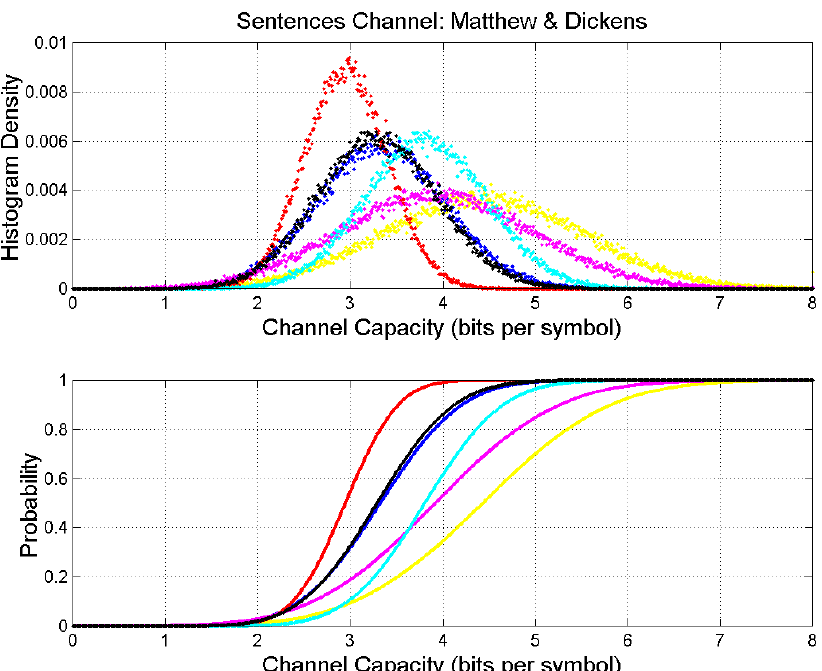
Figure 8. Upper panel : Probability density histograms of self- and cross-channel capacity. ; Matthew : yellow (output); Our Mutual Friend : black; A Tale of Two Cities ; cyan; David Copperfield : red; The Adven- tures of Oliver Twist : blue; Bleak House : magenta. Lower panel : Probability distribution functions.